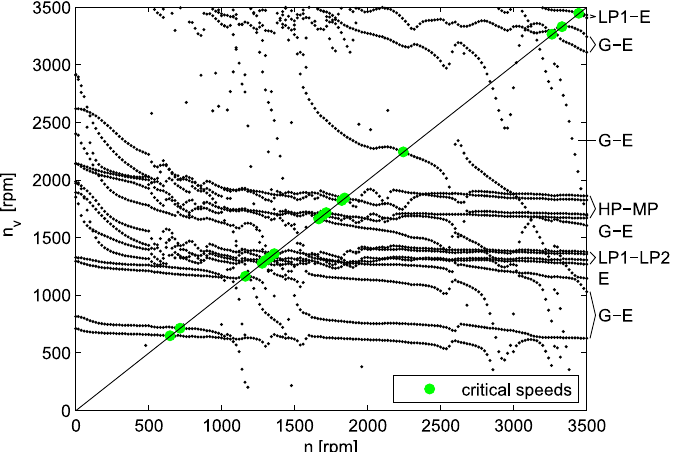
Figure 13. The Campbell diagram calculated using model B (the rotor with bearings and dynamic compliances of the